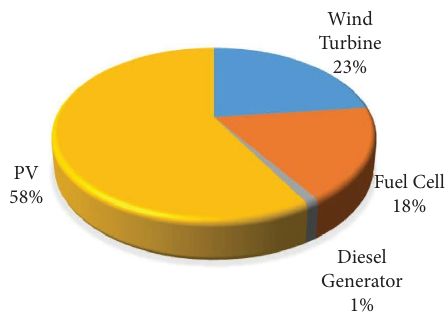
Figure 13: Monthly electrical generation during a